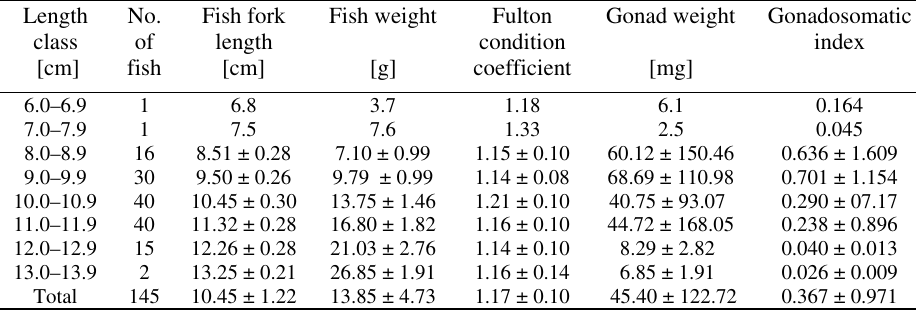
Major characteristics of males studied by length class (